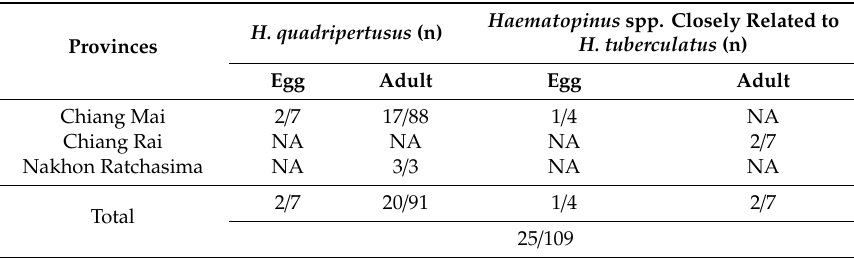
Table 2 . Molecular detection of Bartonella spp. DNA of gltA and rpoB from cattle lice samples collected from three different areas of Thailand .